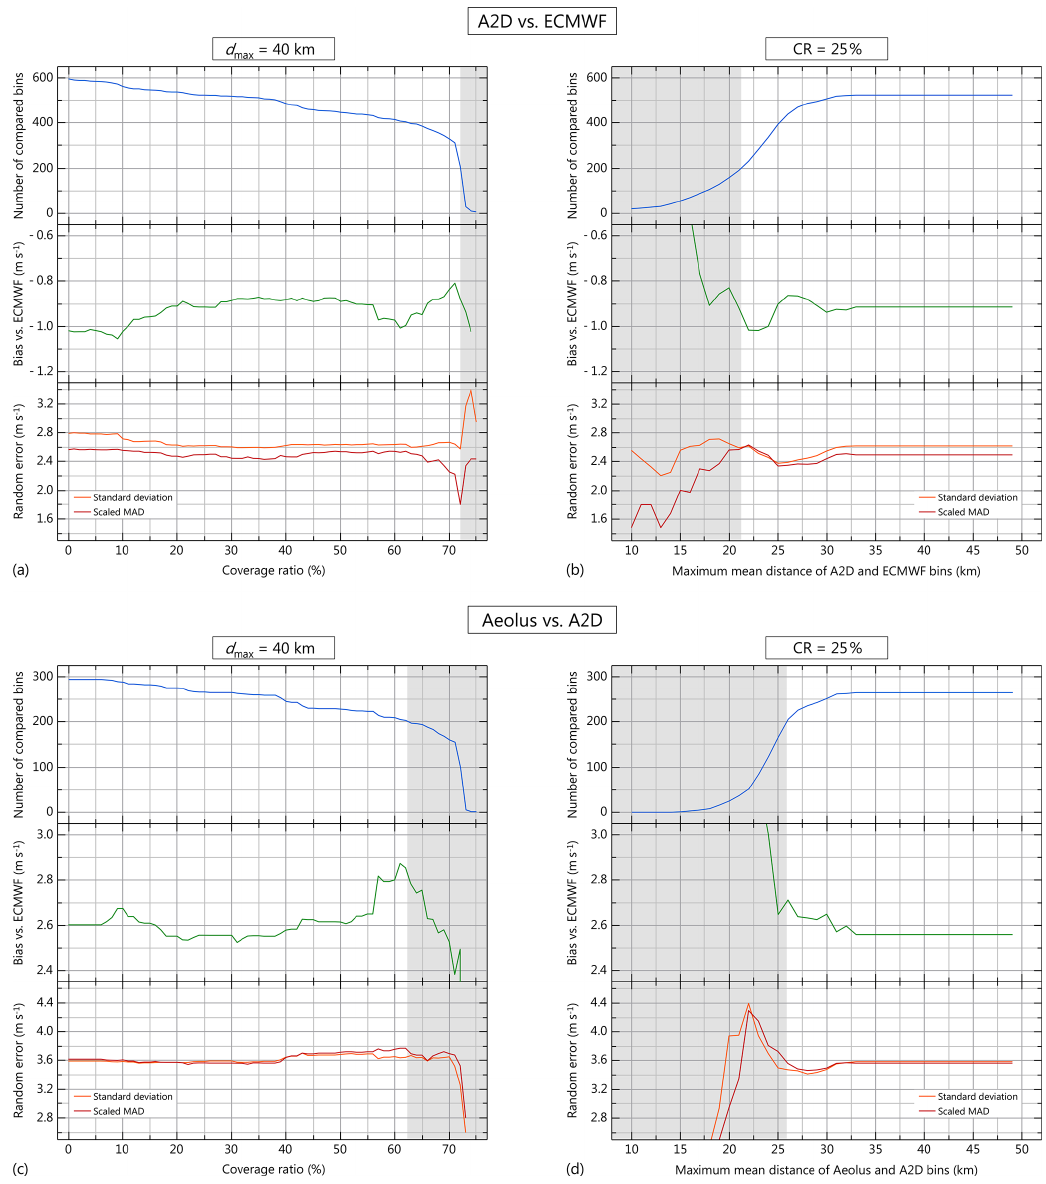
Figure 13. Influence of the (a, c) coverage ratio and (b, d) horizontal distance threshold on the statistical parameters resulting from the A2D– ECMWF comparison (a, b) and the Aeolus–A2D comparison (c, d) . The top panels of each subfigure depict the number of bins included in the statistical comparison, the middle panels show the bias and the bottom panels illustrate the random error (standard deviation and scaled MAD) depending on the respective threshold parameter. Results for which the number of compared bins is below 200 are considered statistically insignificant and are indicated as grey shaded